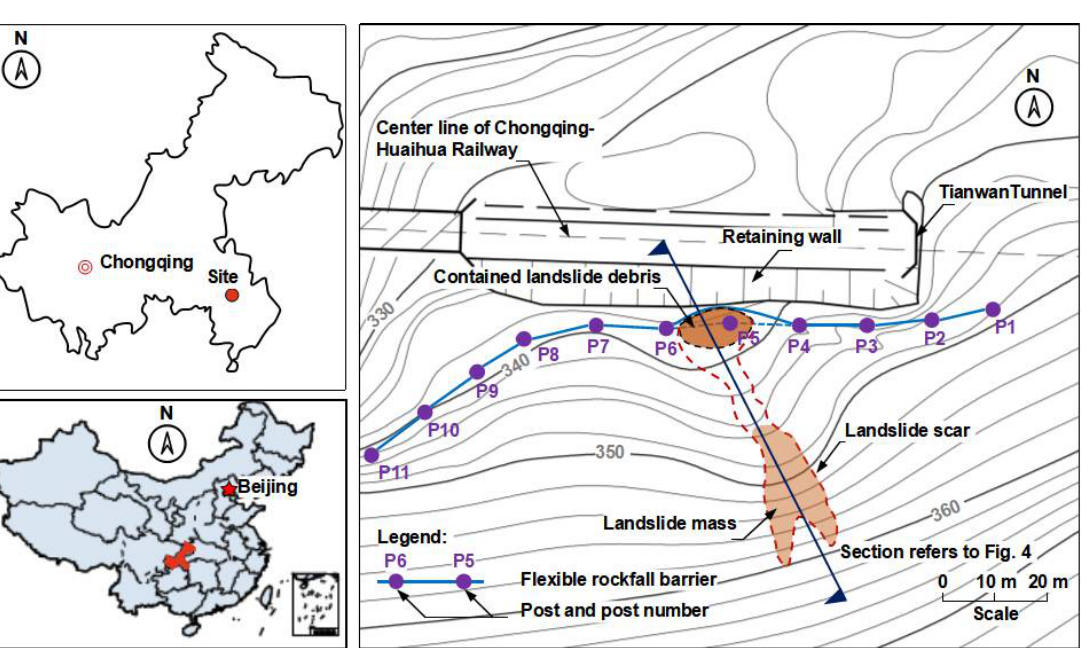
Figure 3. Location of the landslide and the posts of the flexible barrier.